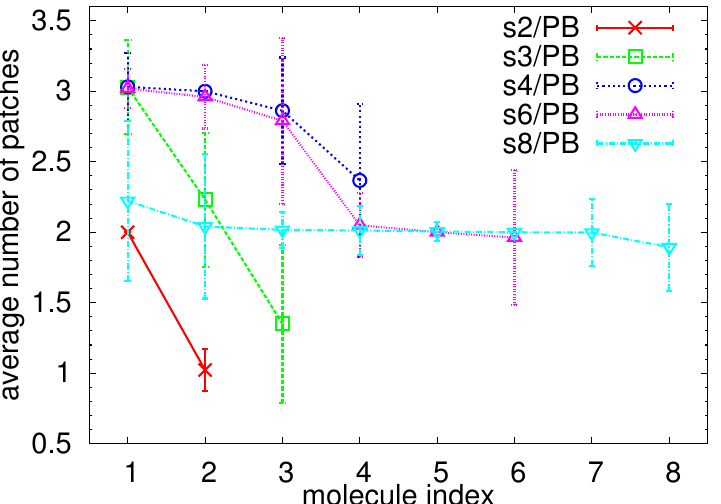
Figure 4. Average number of patches per star plotted as an index of the star in the system. Stars were sorted and labeled in descending order of the number of patches. The lines are guide for the